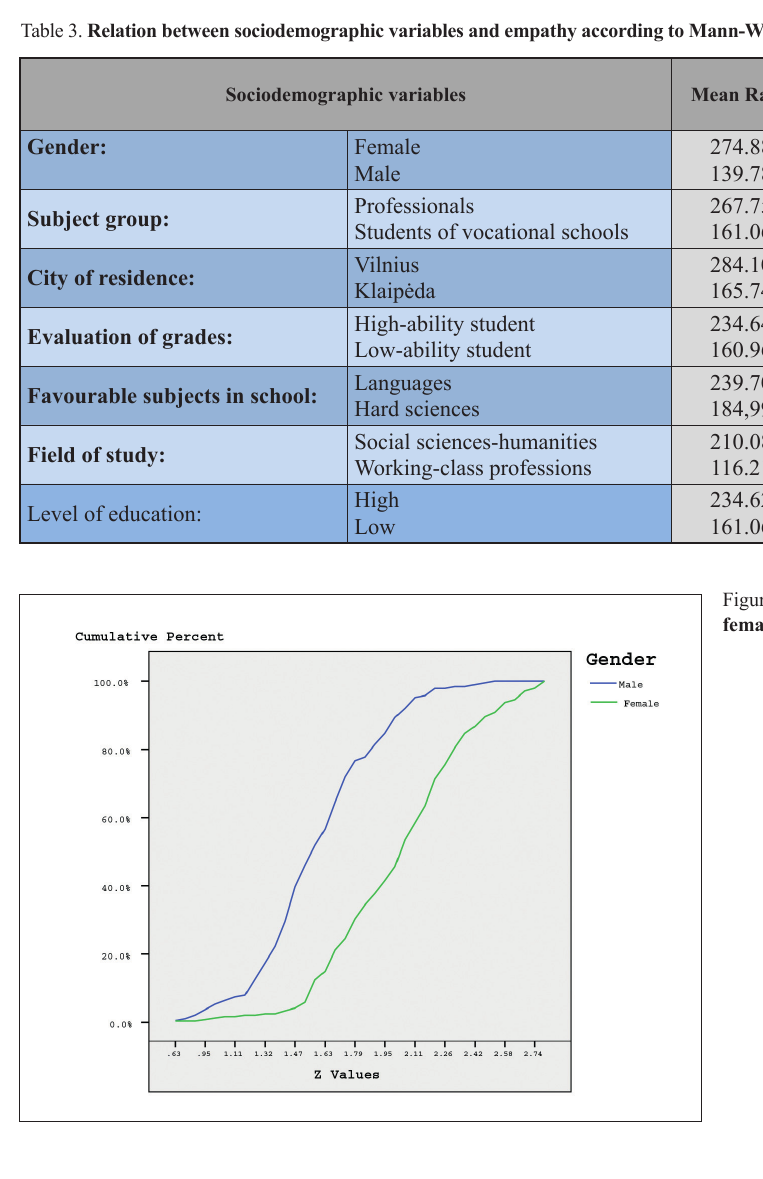
Table 3. Relation between sociodemographic variables and empathy according to Mann-Whitney and Kruskal-Wallis, duplex model, p ≤ .05